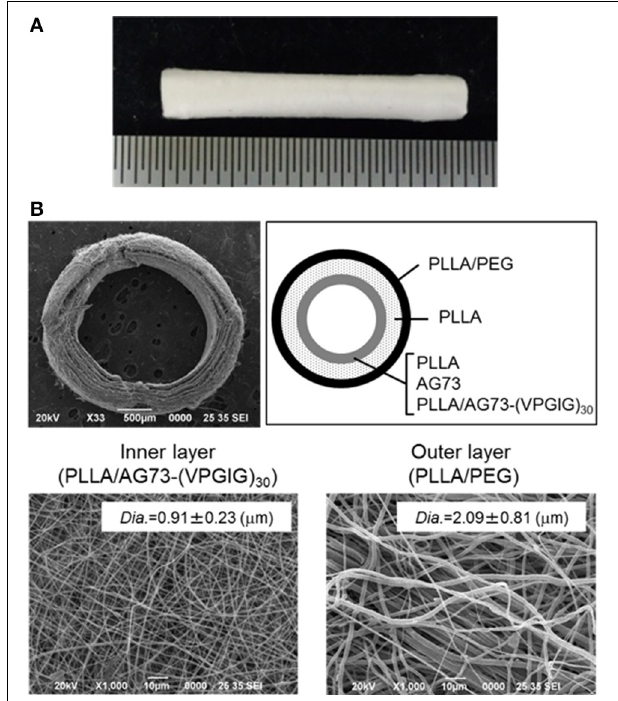
FIGURE 4 | Micro-fibrous nerve conduit with a three-layered structure. (A) Whole image, (B) SEM images of cross-sections and inner and outer